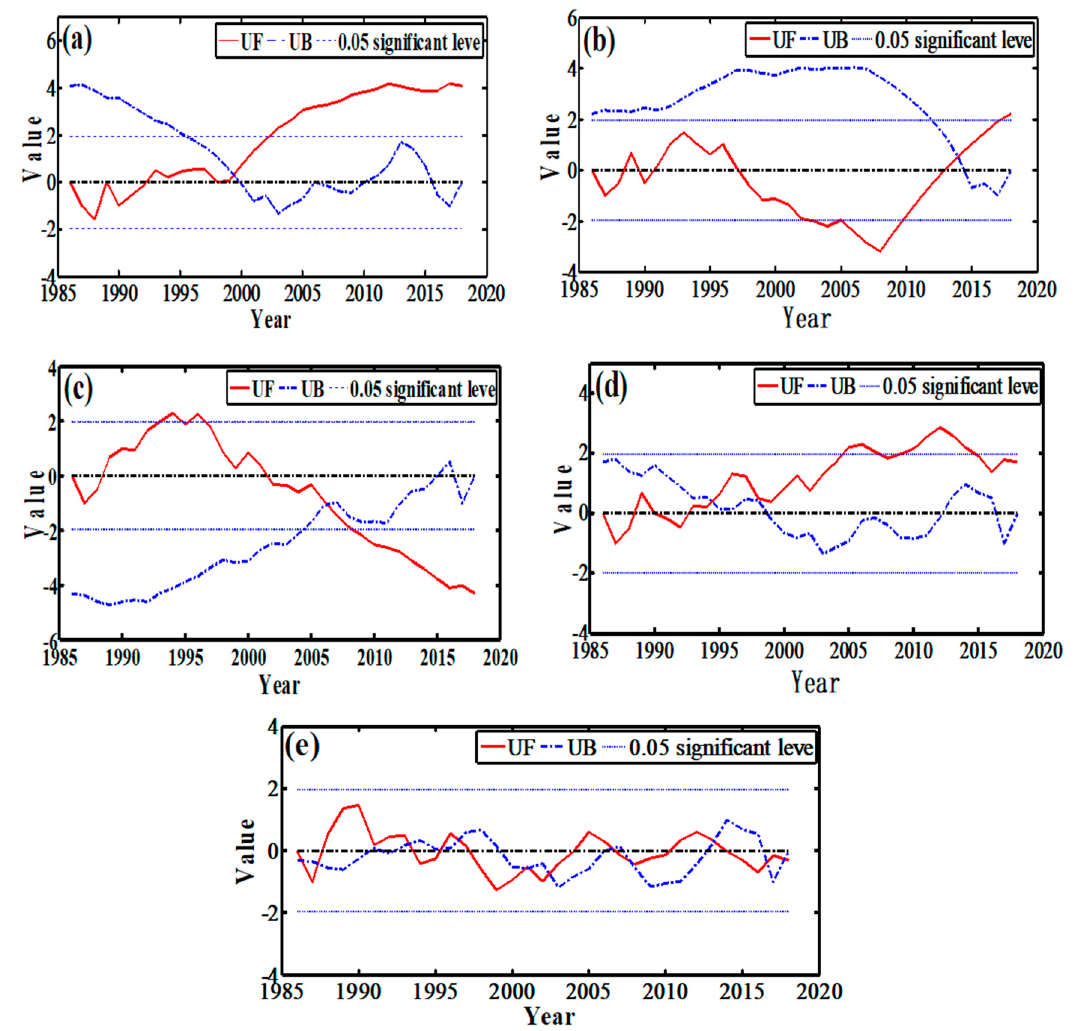
Figure 3. The Mann-Kendall (M-K) trend test for the hydrologic regime from 1986–2018 (( a ) annual water level at the Huangjiagang station; ( b ) annual water level at the Xiangyang station; ( c ) annual water level at the Huangzhuang station; ( d ) annual runoff at the Huangjiagang station; ( e ) annual runoff at the Huangzhuang station). Table 5. Mann-Kendall analysis of changing trends in the hydrological regimes. Factors Z Statistic Sig. Level A Huangjiagang 4.08 0.01 0.04 water level Xiangyang 2.22 0.05 0.12 Huangzhuang − 4.29 0.01 − 0.06 Huangjiagang 1.69 0.1 7.17 runoff Huangzhuang − 0.29 >0.1 2.19